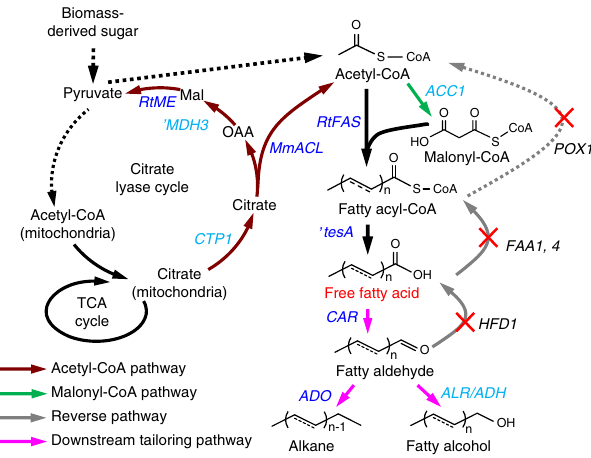
Figure 1 | Establishing a yeast fatty acid platform for production of oleochemicals and biofuels. The dotted lines indicate multiple steps and solid lines a single step. Overexpressed genes are shown in light blue (endogenous) or navy blue (heterologous). Reverse pathways were eliminated by deleting the corresponding genes (marked with X). For FFA production, fatty acyl-CoA synthetase encoding genes FAA1 and FAA4, and fatty acyl-CoA oxidase encoding gene POX1, were disrupted. Furthermore, the truncated E. coli thioesterase ’TesA was overexpressed. For enhancing acetyl-CoA supply, a chimeric acetyl-CoA pathway, consisting of ACL (MmACL) from Mus musculus , ME (RtME) from Rhodosporidium toruloides